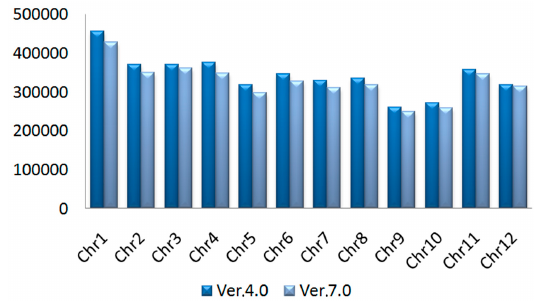
Figure 1. Single nucleotide polymorphisms (SNPs) in different chromosomes in rice genome 4.0 and 7.0. Chr mean chromosome. The same as below.